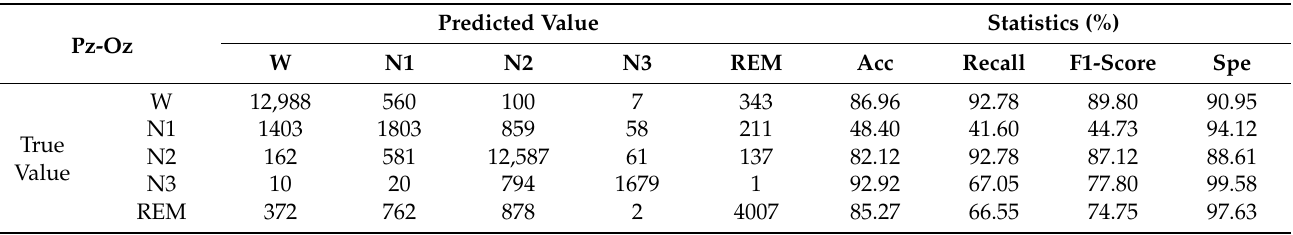
Table 4. Confusion matrix and classification performance of each class of the sleep EEG signal deep learning model based on bidirectional RNN on Pz-Oz channel.